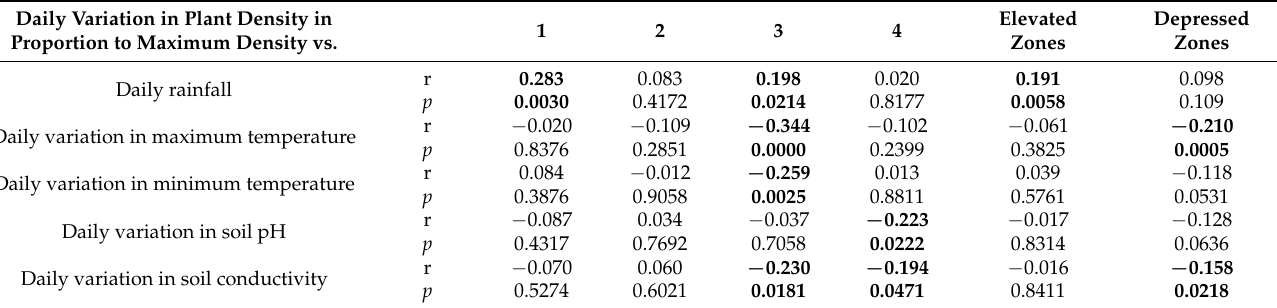
depressed zones. Significant values are marked in bold ( p <